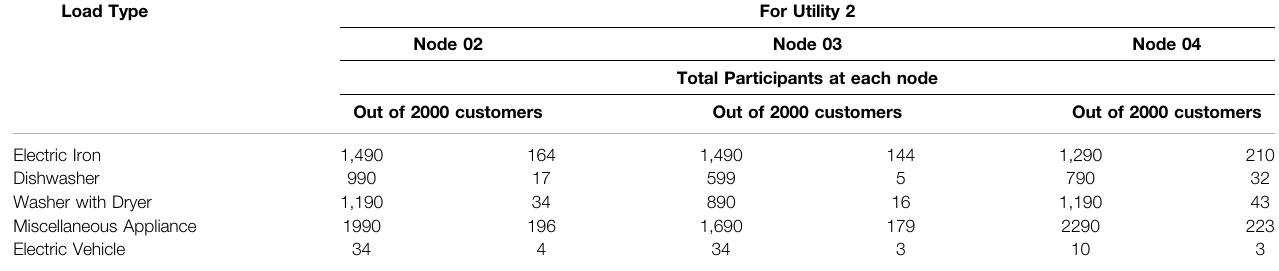
TABLE 4 | Number of reschedule forecasts in utility two.